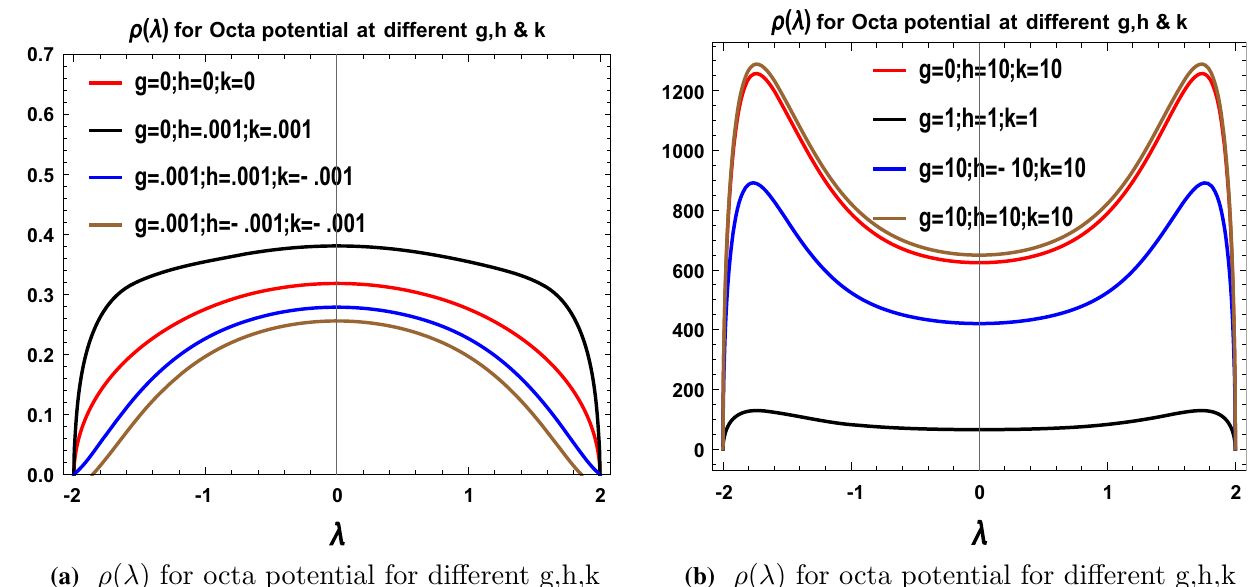
Fig. 31 Eigen value distribution curve of density function for quartic and octa potential for different parameter values. Here we fix a = 1